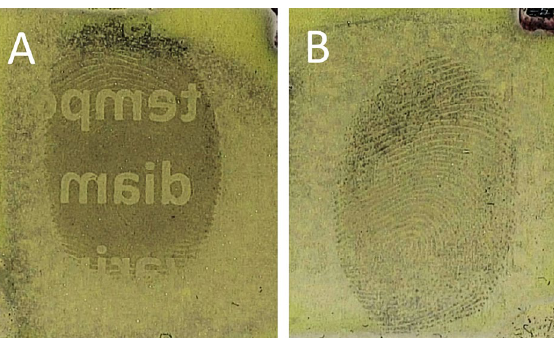
Figure 5. Gelatin lifted samples of fingermarks placed prior to printing prose ( A ), and on top of printed prose ( B ), developed in the RECOVER